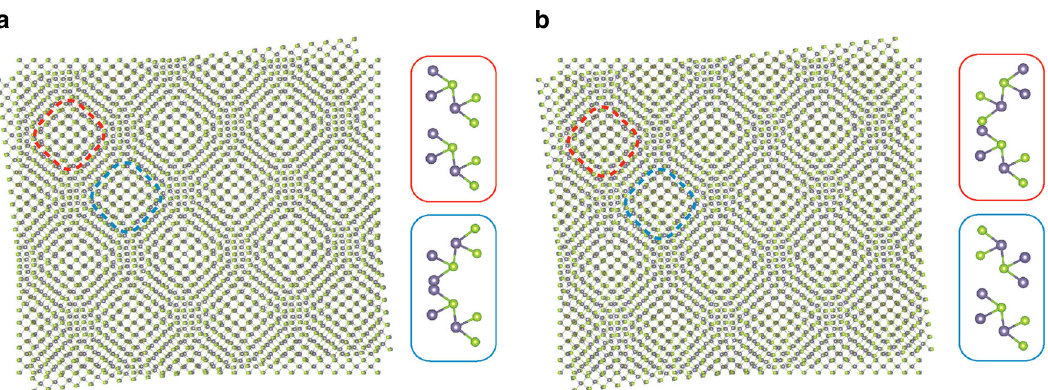
Fig. 4 The two con fi gurations of twisted bilayer GeSe in real space: a con fi guration A and b con fi guration B. They are related by a 180 (cid:1) rotation of the top layer and share the same size of supercell. The insets show the local atomic arrangements in the regions highlighted in red and blue in the main fi gures.